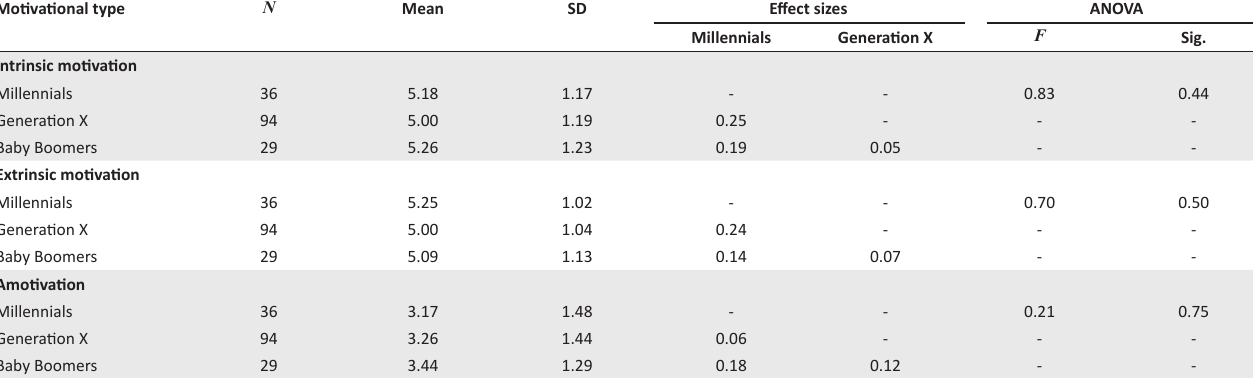
TABLE 2: Descriptive statistics, analysis of variance and effect size results for extrinsic and intrinsic motivation. Motivational type